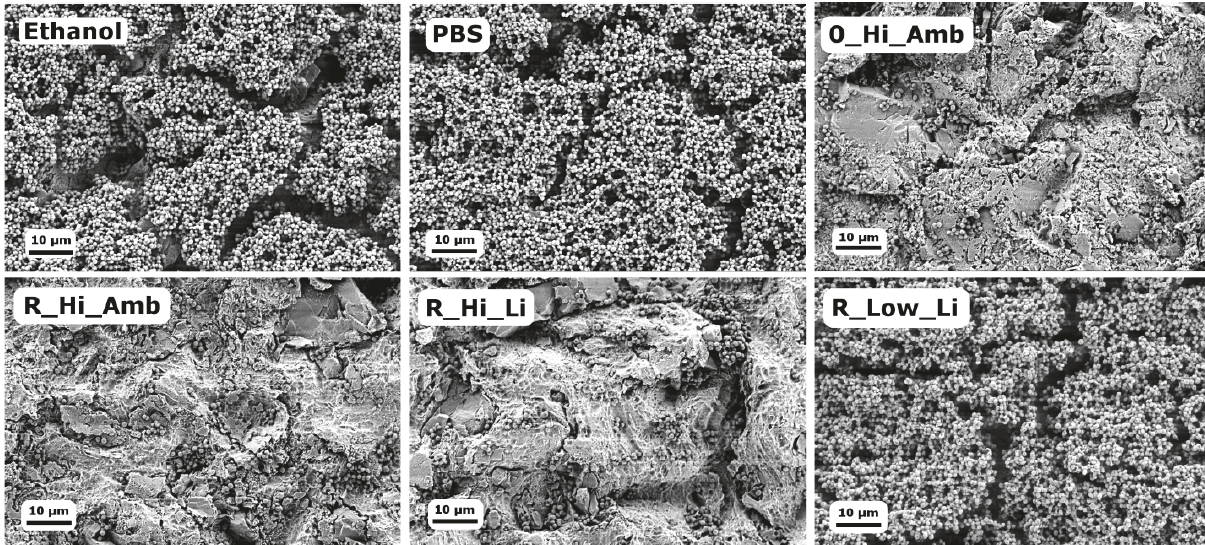
Figure 4: SEM micrographs of S. epidermidis on the Ti surfaces after the different debridement